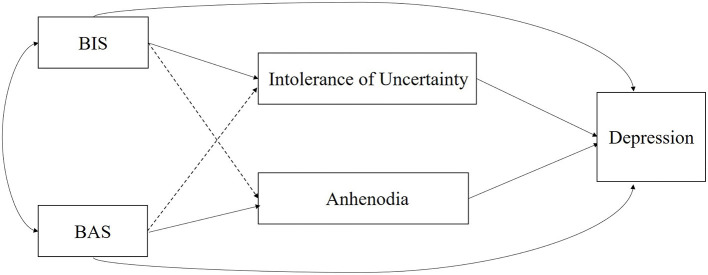
The supposed model.